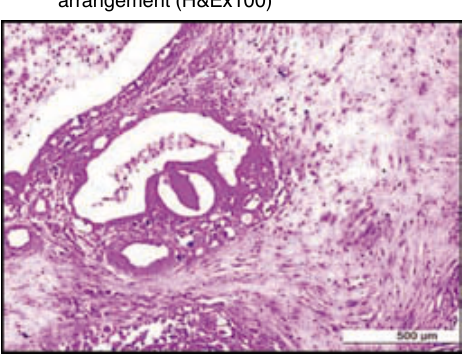
Fig.9. Anaplastic carcinoma - neoplastic cells often seen in small nests - round, oval or polygonal in shape (H&Ex100)